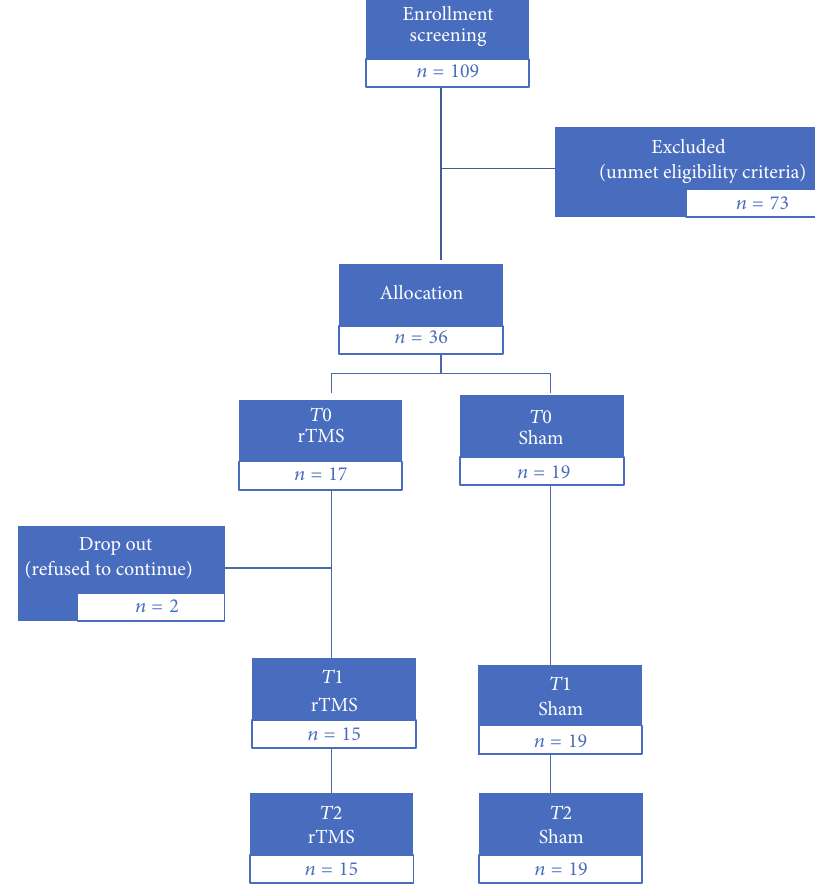
Figure 1: Flow diagram of referred and enrolled